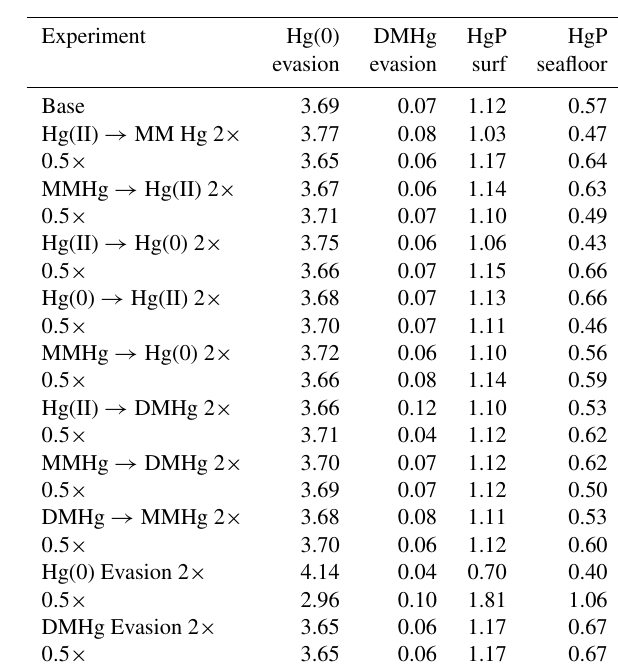
Table 1. Fluxes (in Mmolyr − 1 ) from model kinetic rate constant sensitivity